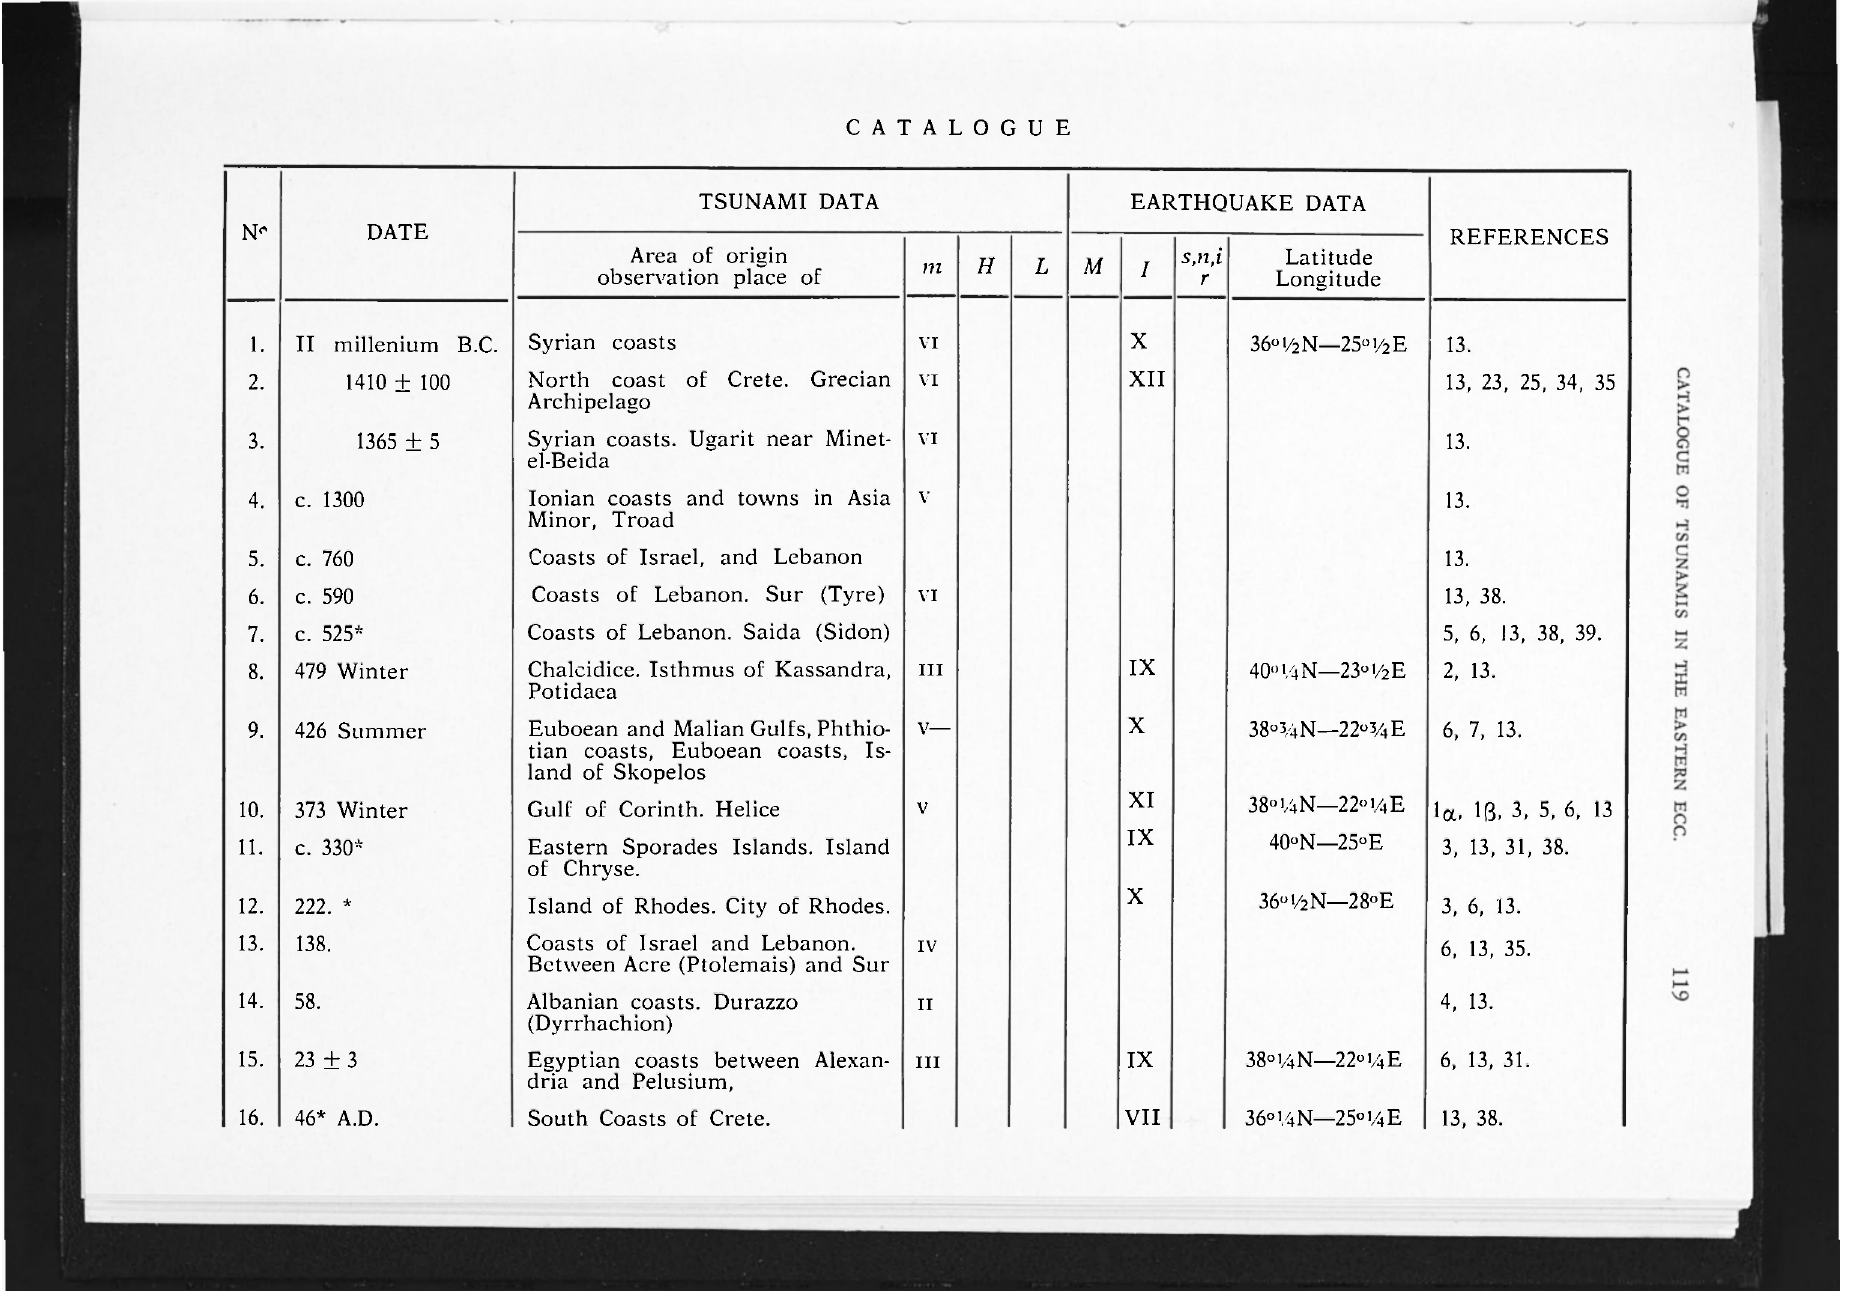
TSUNAMI DATA EARTHQUAKE